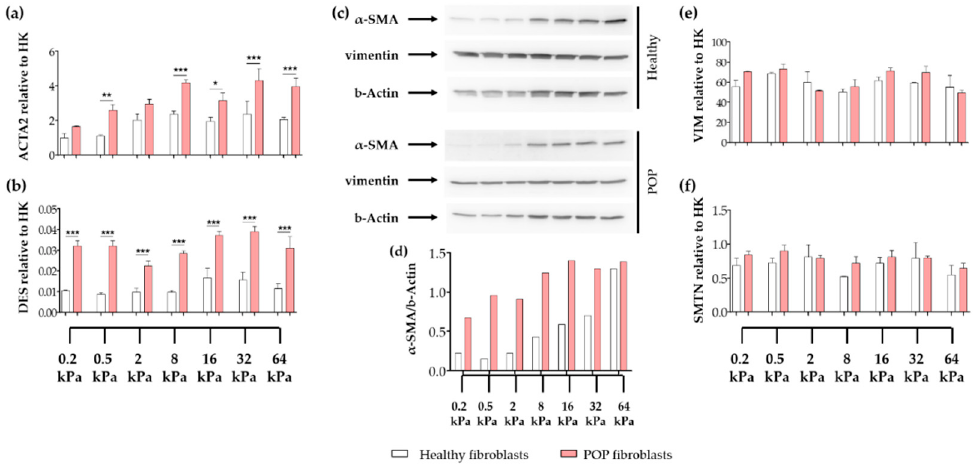
Figure 1. Expression of intracellular proteins of vaginal fibroblasts on different substrate stiffnesses. Healthy or pelvic organ prolapse (POP) fibroblasts were seeded for 48 h on collagen coated plates with specific stiffnesses: 0.2 kPa, 0.5 kPa, 2 kPa, 8 kPa, 16 kPa, 32 kPa or 64 kPa. The graphs show the relative gene expression to house-keeping genes (HK) of the genes: ( a ) ACTA2 (alpha smooth muscle actin or α -SMA), ( b ) DES (desmin), ( e ) VIM (vimentin) and ( f ) SMTN (smoothelin). ( c ) Western blots showing protein levels of α -SMA, vimentin and b-Actin. ( d ) Corresponding quantification of the density of the bands of α -SMA normalized to b-Actin. Data represents the mean ± SD. * p < 0.05, ** p < 0.01, *** p < 0.001 by one-way analysis of variance (ANOVA), followed by Tukey’s multiple comparison test.